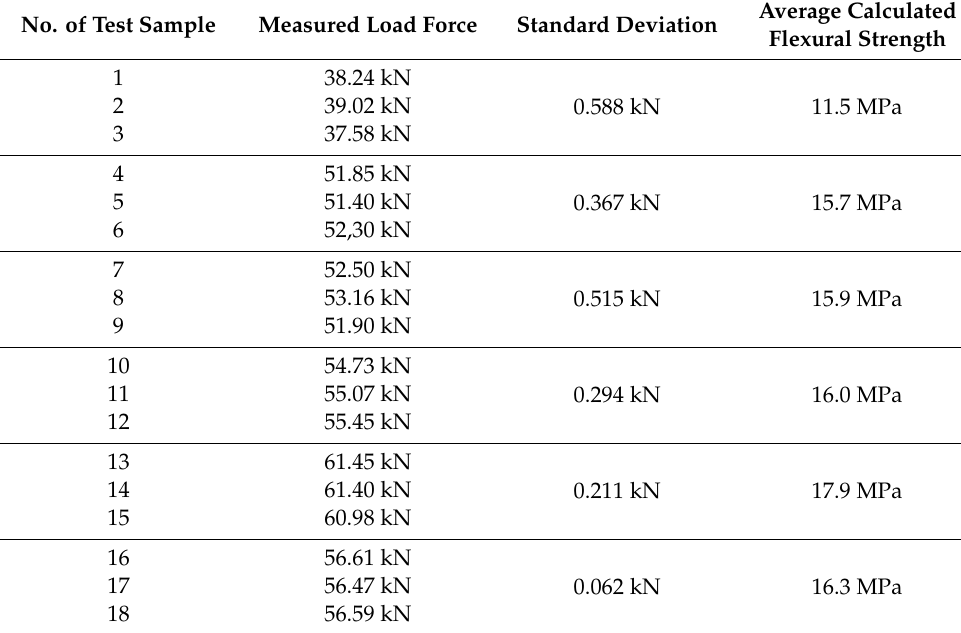
Table 4. The measured load force values and the average calculated flexural strength values.